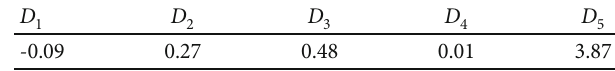
Table 3: Johnson-Cook failure